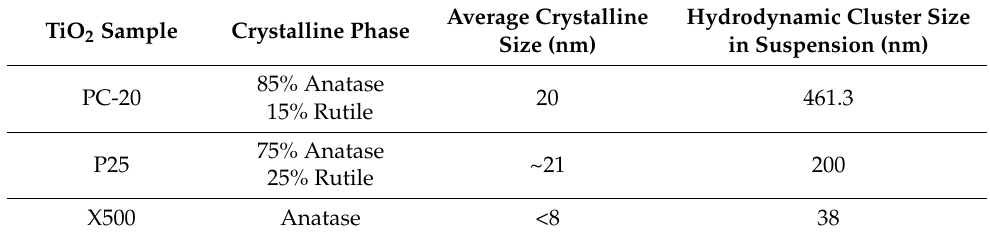
Table 1. Characteristics of TiO 2